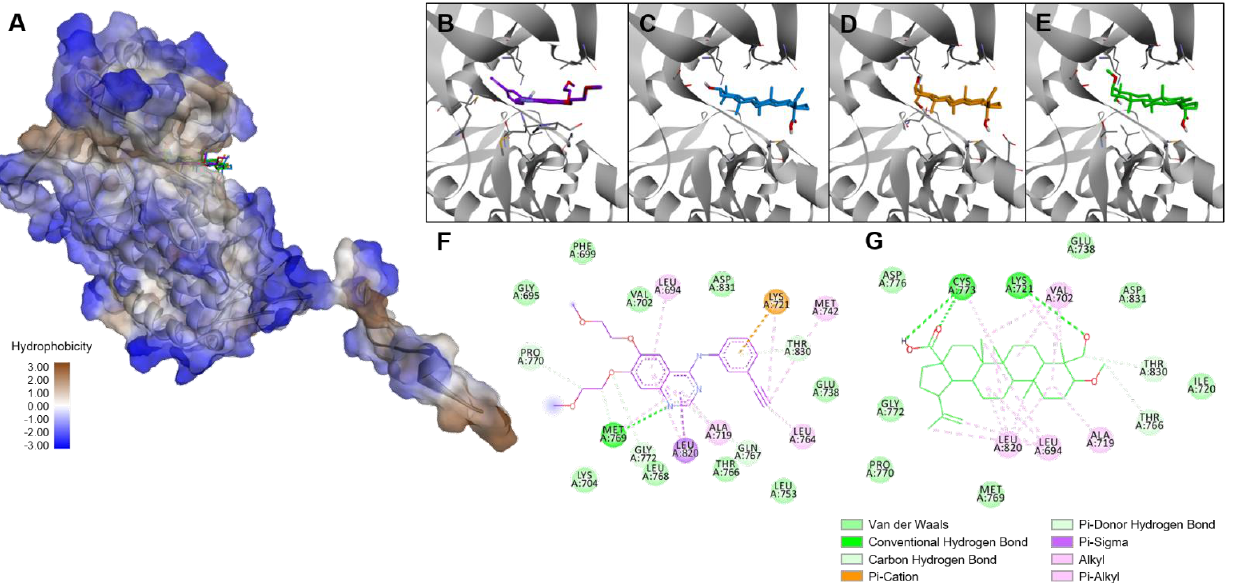
Figure 7. Binding modes of T1m in the EGFR tyrosine kinase domain. ( A ) Superimposed poses inside inhibitor binding site. Close-up of the binding site with ( B ) erlotinib (Re − docking RMSD: 1.722 Å), ( C ) betulinic acid, ( D ) compound T1, and ( E ) compound T1m . Interactions of EGFR tyrosine kinase domain with ( F ) erlotinib and ( G ) T1m .